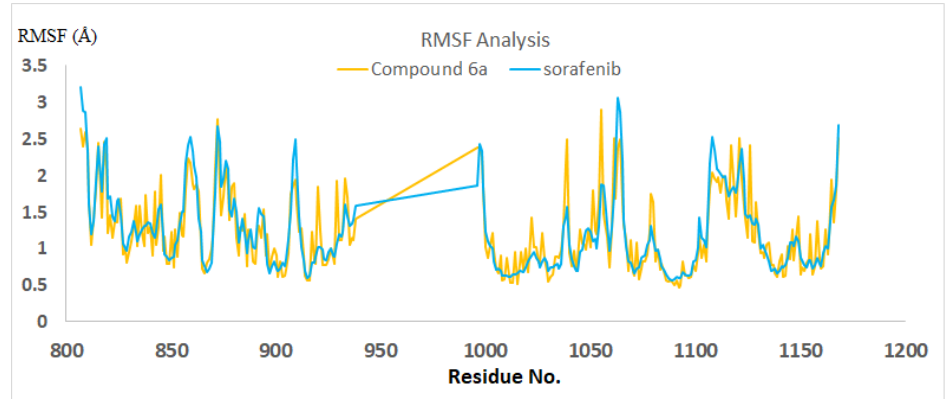
Figure 6. The RMSD values for sorafenib- VEGFR-2 (blue) and compound 7d -VEGFR-2